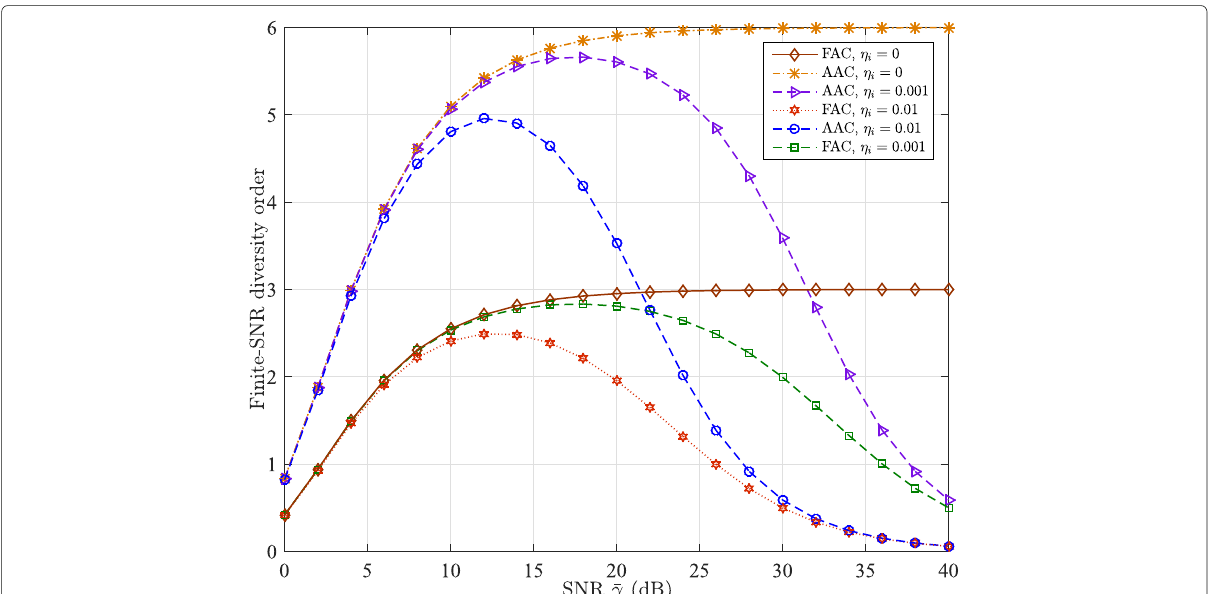
Fig. 2 Finite-SNR diversity orders of the proposed joint relay-antenna selection schemes versus the transmit power with different self-interference levels for K = 3